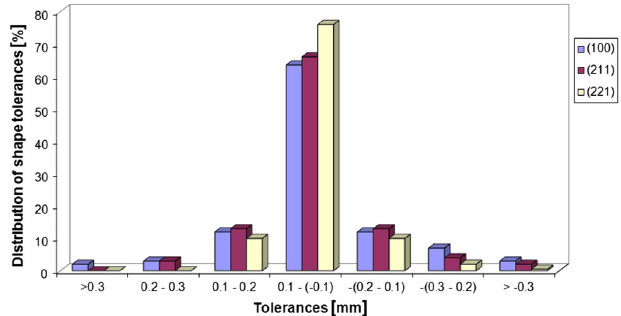
FIG. 10. Dependence of the half-cell shape accuracy on the crystal orientation of the main central crystal. Disks with (100) orientation show bigger deviation from